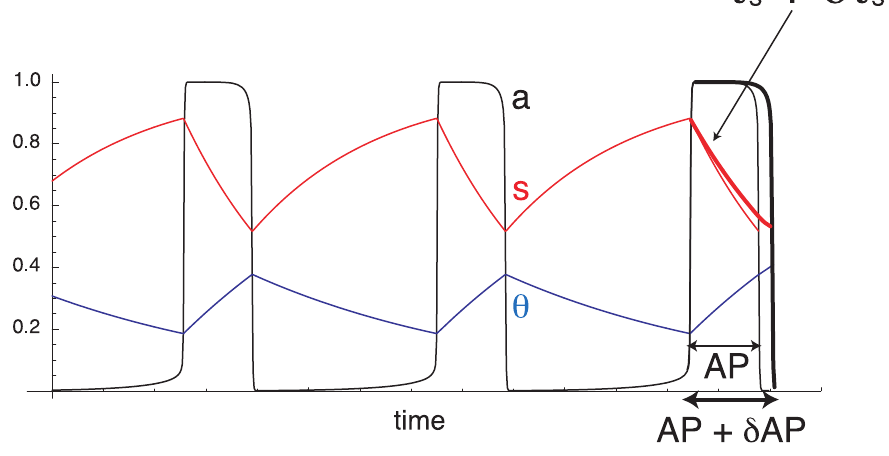
Figure 4. Construction of a measure of the contribution of s to episode termination. Increasing t s by dt s at the beginning of an episode slows down s slightly (thick red curve), so the active phase is lengthened by d AP (thick black curve).